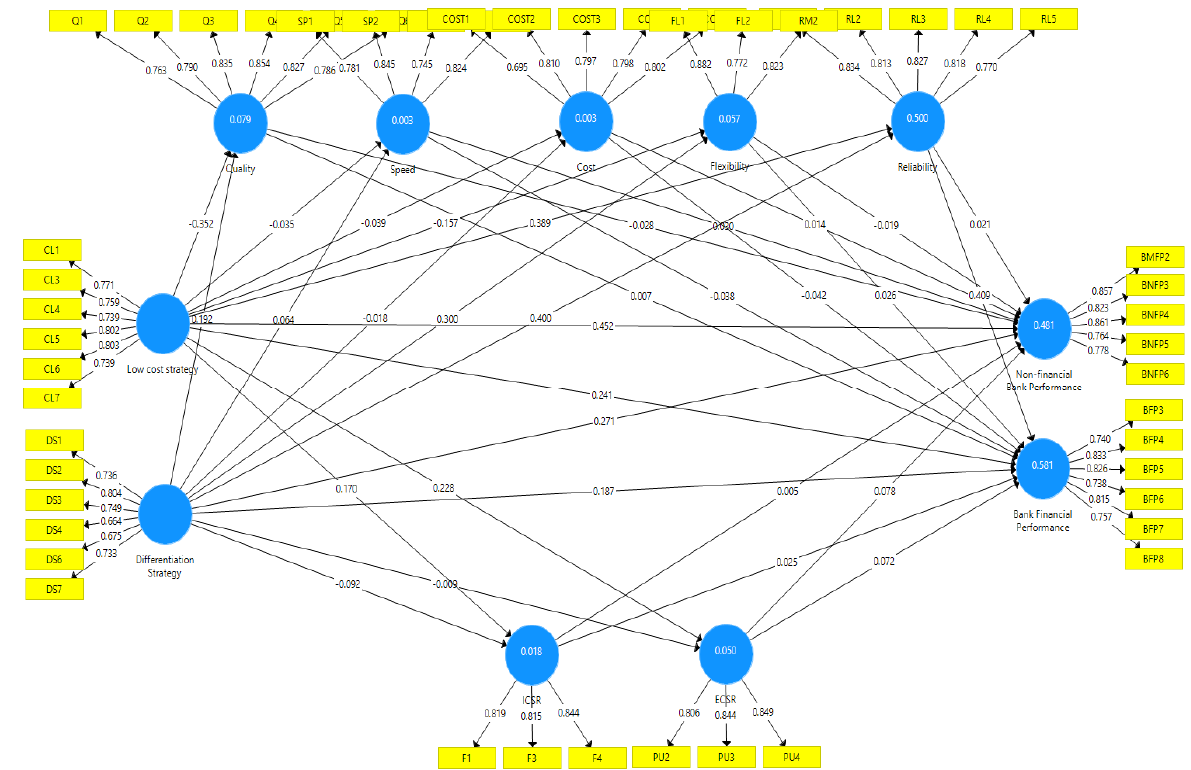
Figure 2. Measurement Model Assessment . Table 2. Reliability and validity.